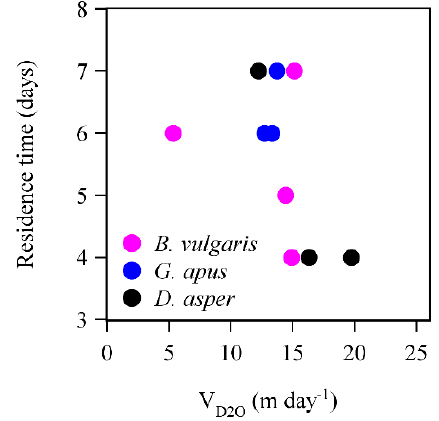
Figure A4. Residence time in relation to the sap velocity estimated by TDP ( V TDP , m day − 1 ). Table A1. Testing result of the homogeneity of variance among the unbalanced data. The tested water transport characteristics based on deuterium tracing on four culms for B. vulgaris and three culms for G. apus and D. asper : times when deuterium arrived in the canopy ( T arrival , days), reached the maximum concentration ( T max , days) and amount of time it remained in the bamboos ( T residence , days). Derived daily water use (WU D2O , kg day − 1 ) and daily sap velocity ( V D2O , m day − 1 ). ‘ P > 0.05 ( P r > F )’ indicate equal variance among species.